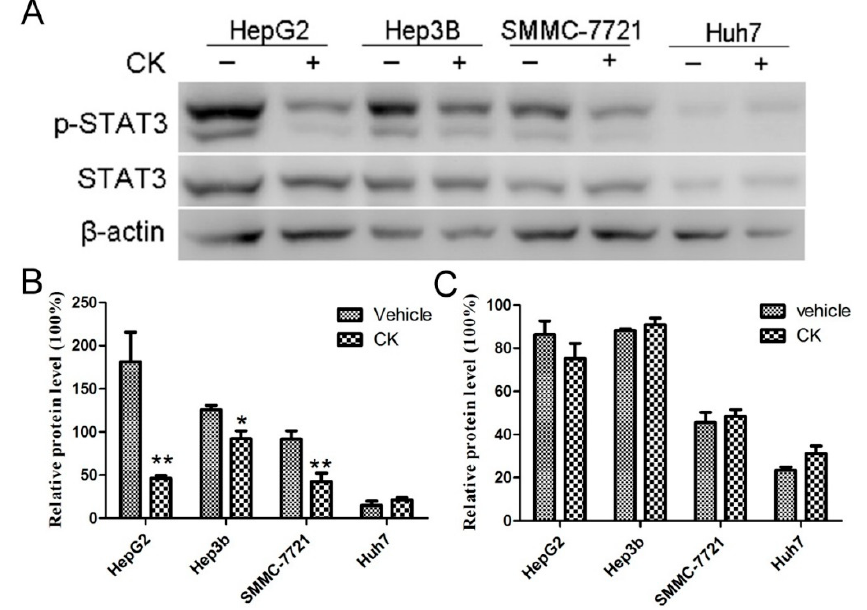
Figure 2. CK reduced p-STAT3 levels in different HCC cell lines. ( A ) Western blot analysis of STAT3 and p-STAT3 levels in different HCC cell lines. ( B , C ) Quantification of (B) p-STAT3 and ( C ) STAT3 levels normalized to β -actin. Data are presented as mean ± SD; Statistics were done by one-way ANOVA and Dunnett text. * p < 0.05, ** p < 0.01 vs. Vehicle.